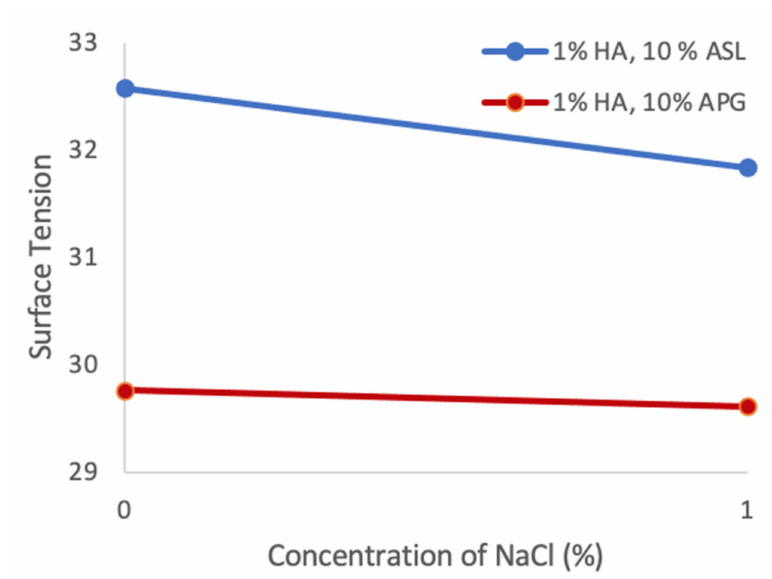
Figure 10. Effect of NaCl concentration on surface